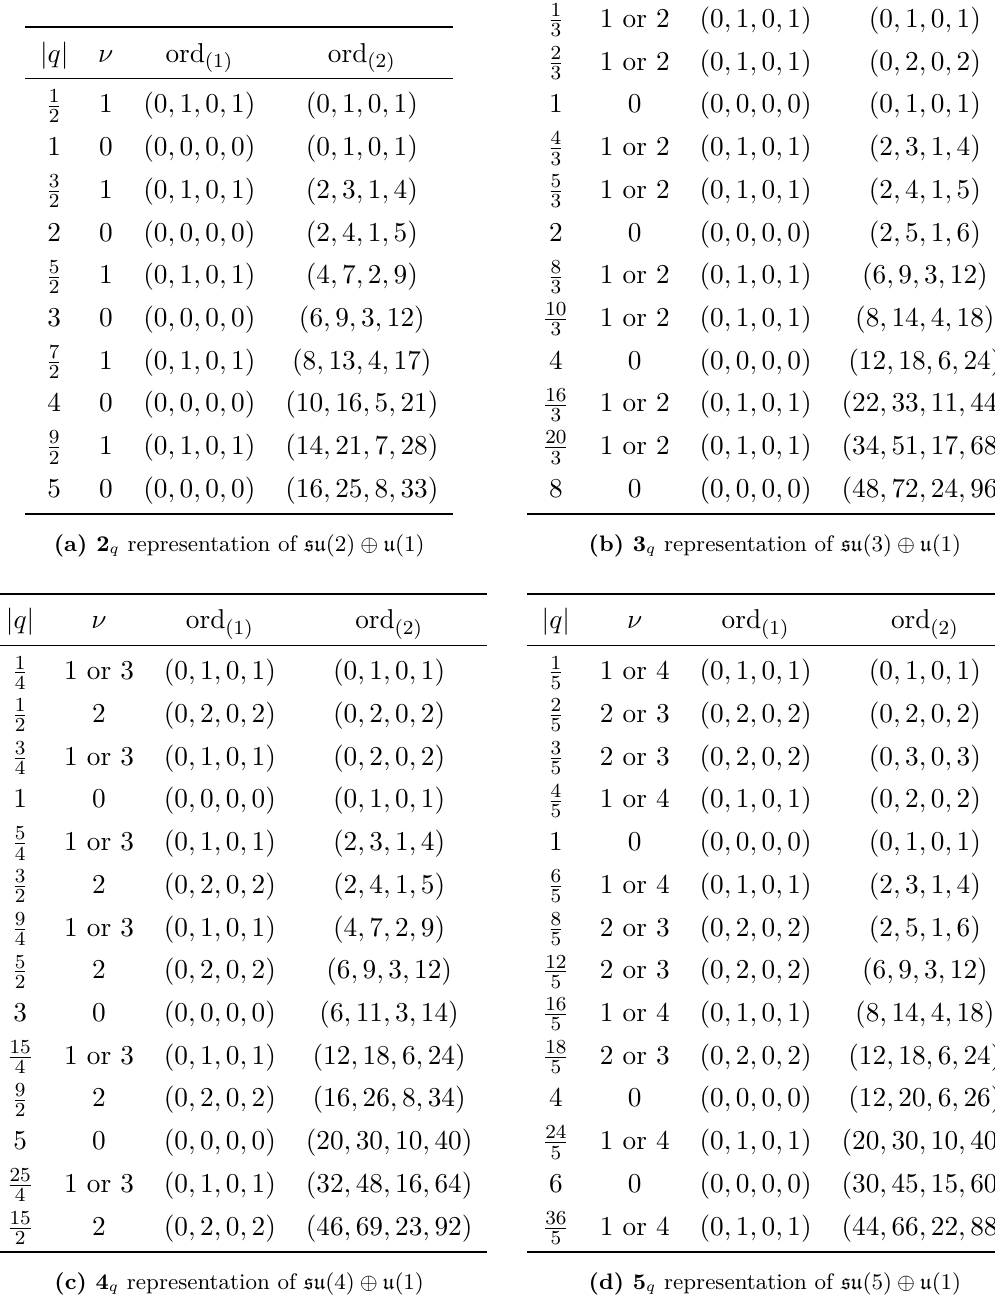
Table 10. Orders of vanishing of (ˆ x, ˆ y, ˆ z, ˆ w ) for various combinations of ν and pseudo-charge q for fundamental matter of su ( n ) ⊕ u (1) with 2 ≤ n ≤ 5 . The su (2) ⊕ u (1) data are found using the model in eq. (7.6), the su (3) ⊕ u (1) and su (5) ⊕ u (1) data are found using the model in eq. (7.3), and the su (4) ⊕ u (1) data are found using the seed model for fundamentals with even n